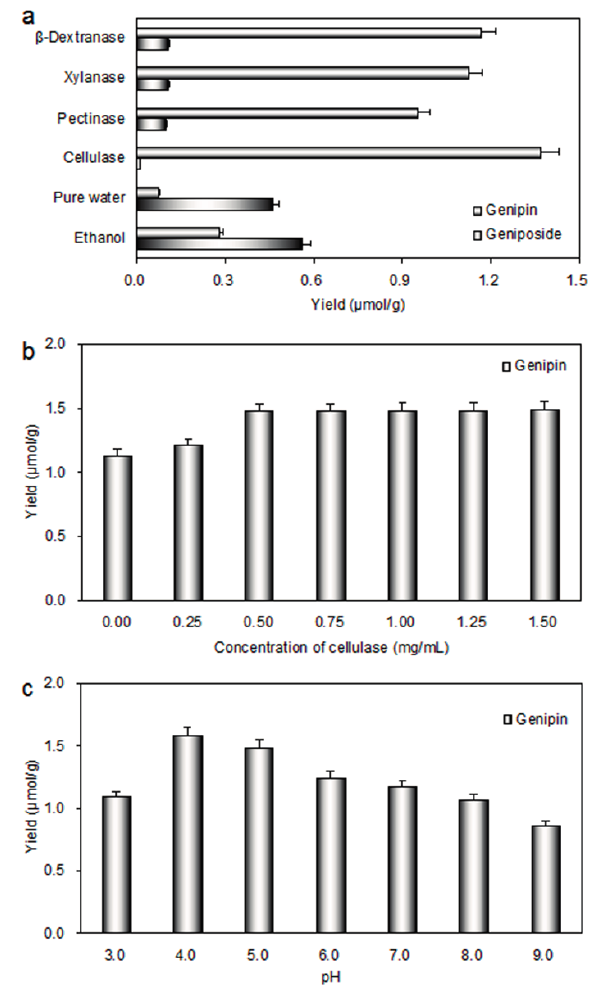
Figure 3. Effect of different parameters in EHSE process on the yield of genipin: ( a ) enzyme types; ( b ) concentration (mg/mL); and ( c ) pH. One gram degreased sample powder was